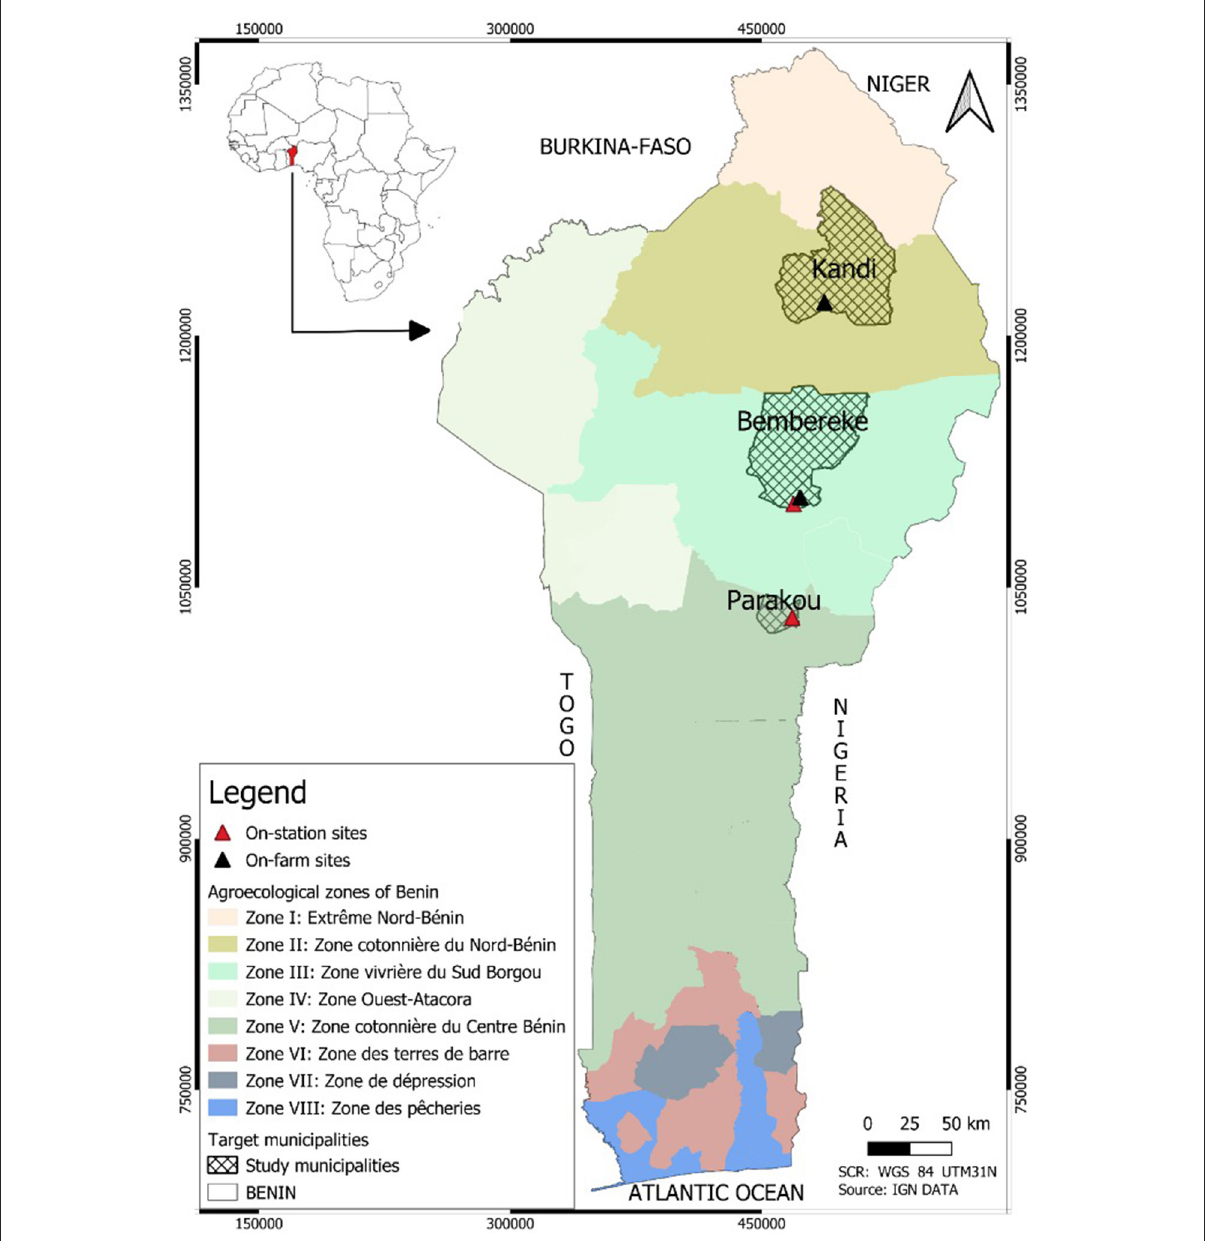
FIGURE1 Map of Benin showing the location of the three sites (Parakou, Bembereke and Kandi) in Northern Benin.